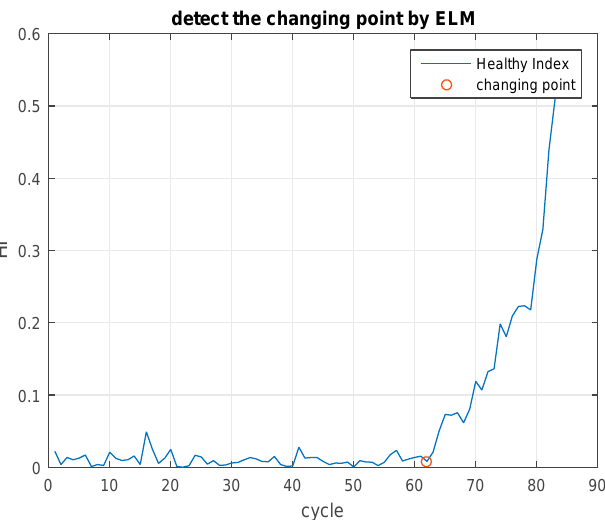
Figure 10. HI and changing point of CS2-35.